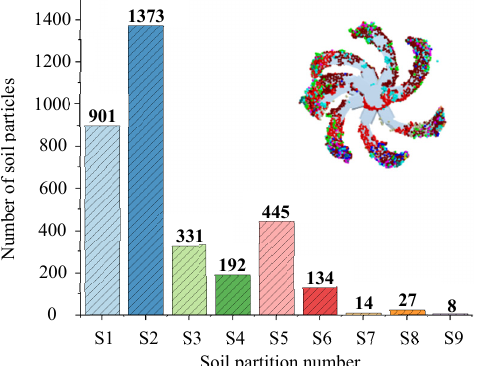
Figure 9. The number of soil particles adhering to the rotary tillage part.